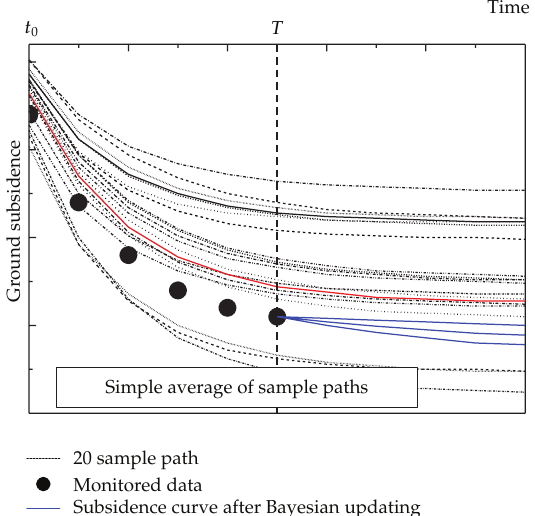
Figure 1: Bayesian updating on mixed ground subsidence